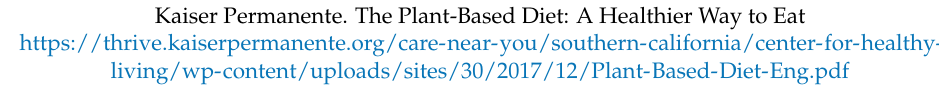
Table 1. Helpful resources for a healthy plant-based diet (sites accessed 9 April 2020). Kaiser Permanente. The Plant-Based Diet: A Healthier Way to Eat